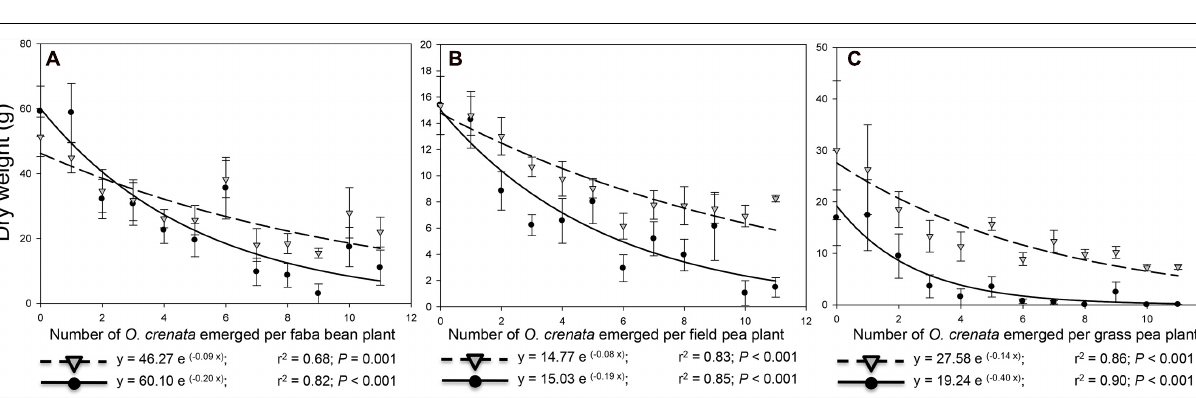
FIGURE 1 | Relationship between total dry weight and infection severity measured as O. crenata emergence per host plant. Dry weight of infected system (combined host + O. crenata ; (cid:4) ), host dry weight ( (cid:79) ), cumulative O. crenata dry weight (